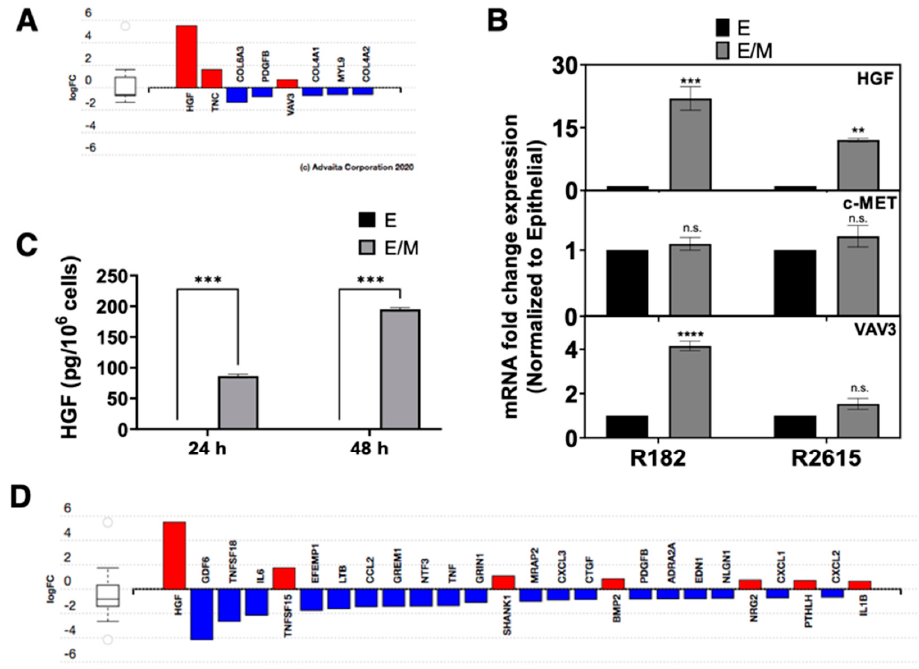
Figure 6. DEGs related to focal adhesion reorganization and signaling receptor activity in the E/M hybrid compared to E cells. ( A ) Bar plot of the logFC of DEGs related to focal adhesion reorganization. ( B ) Validation of HGF, c-MET, and VAV3 mRNA expression quantified by q-PCR in the E/M and M state from the R182 and R2615 cells. Bars represent the means ± SEM; p -value ** < 0.01 and *** < 0.001, n.s. = non-significant. One-way ANOVA was used to define the p -value. ( C ) Quantification of secreted HGF using the ELISA-based assay for the E and E/M cells for 24 and 48 h of culture in OPTIMEM media. Bars represent the means ± SEM; p -value *** < 0.001. Student t -test was used to define the p -value. ( D ) Bar plot of the log FC of the DEGs related to signaling receptor activity. **** <